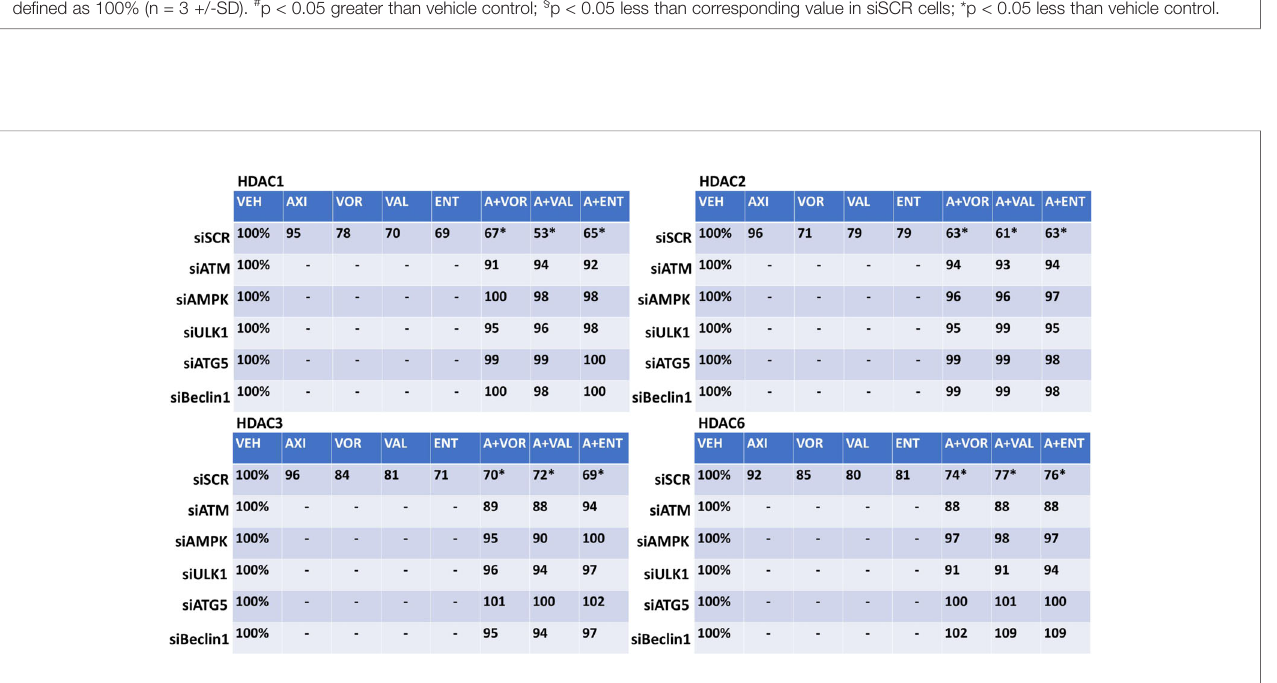
FIGURE 5 | Axitinib combined with HDAC inhibitors reduces the expression of multiple HDAC proteins in HT1080 cells via ATM-AMPK signaling and ULK1- autophagy. HT1080 cells were transfected with a scrambled control siRNA (siSCR) or with validated siRNA molecules to knock down the expression of ATM, AMPK a , ULK1, ATG5 or Beclin1. Twenty-four h after transfection, cells were treated with vehicle control, axitinib (50 nM), entinostat (50 nM), vorinostat (500 nM), sodium valproate (250 m M) alone or in combination as indicated in the graphical panels for 6h. Cells were fi xed in place and in-cell immunoblotting performed to determine the total protein levels of HDACs 1, 2, 3, and 6, and of invariant ERK2. The percentage expression is presented for each HDAC protein corrected for total ERK2 protein loading with vehicle control of each transfection being de fi ned as 100% (n = 3 +/-SD). *p < 0.05 less than HDAC inhibitor alone exposure.